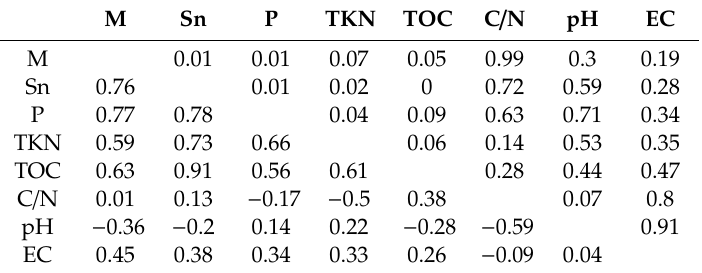
Table 2. An soil parameters’ correlation coe ffi cients (left down) and corresponding p -values (right up); significant cases are highlighted.